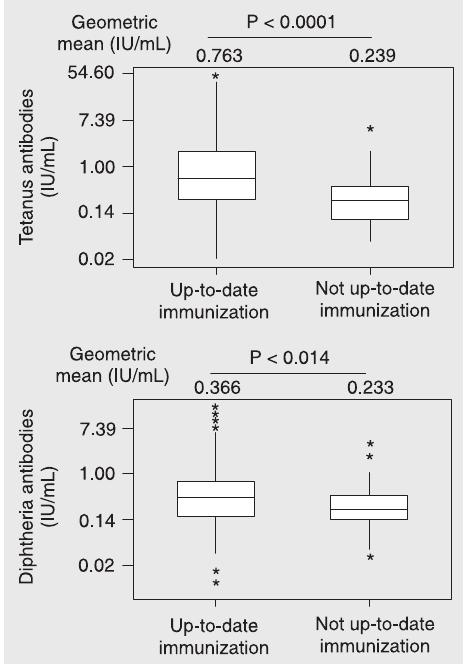
Figure 2. Logarithmic scale of tetanus and diphtheria antibody levels in adolescents with up-to- date and not up-to-date immuni- zation. Horizontal lines in box plots indicate the 25th, 50th, and 75th percentiles; top and bottom vertical lines mark extreme val- ues and, when present, aster- isks represent outlying values. P values compare antibody levels for tetanus and diphtheria in groups with up-to-date to not up- to-date immunization (Student t -